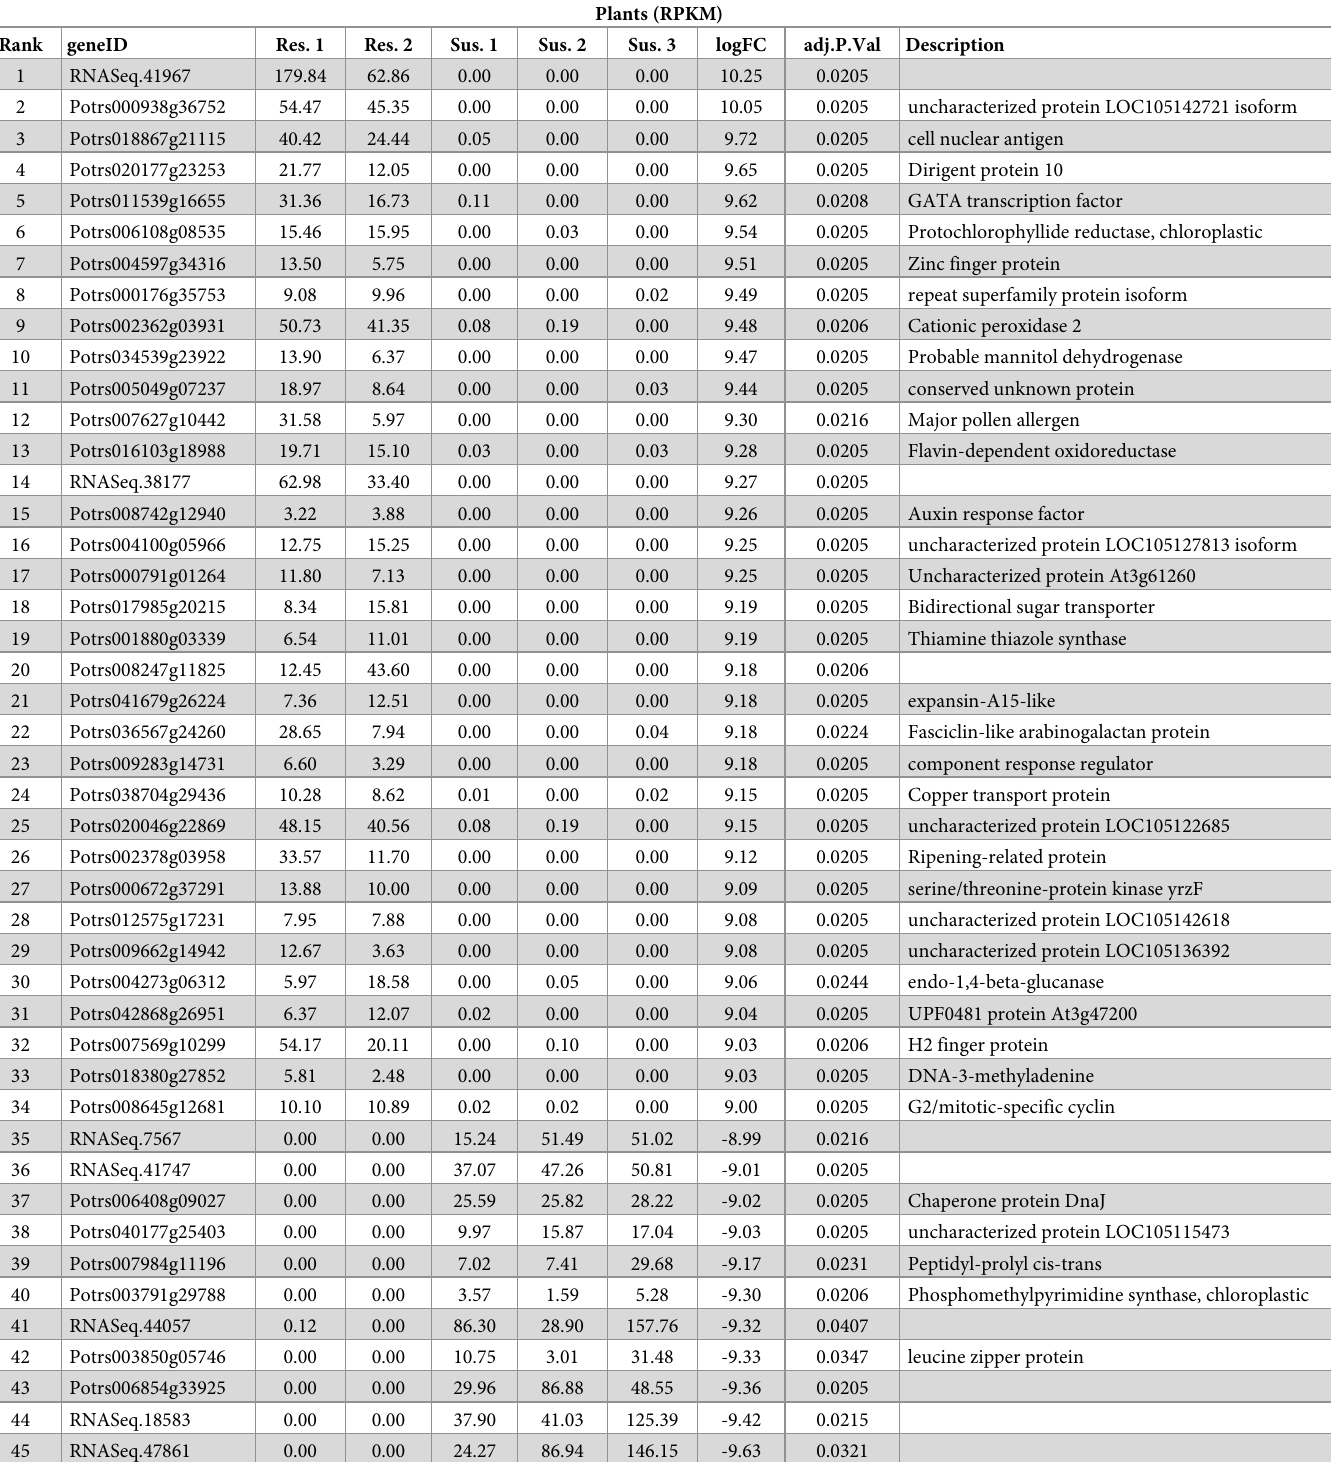
Table 1. Top 50 differentially expressed genes (up or downregulated) in resistant trembling aspen ( Populus tremuloides ) genotypes compared to susceptible trem- bling aspen genotypes based on LogFC. Rank